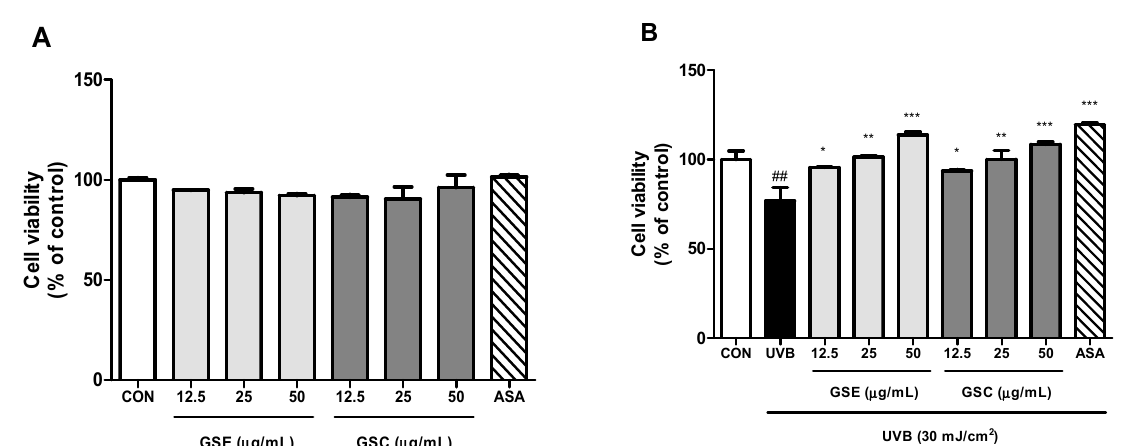
Figure 1. Effects of ginseng seed embryo (GSE) and coat (GSC) on Hs68 cells. ( A ) Cytotoxic effect of GSE and GSC on Hs68 cells was evaluated using MTT assay. ( B ) Protective effect of GSE and GSC in UVB-irradiated Hs68 cells was evaluated using MTT assay. Values are expressed as the mean ± standard error ( n = 3). ## p < 0.01, significant difference compared to control; *, **, and *** p < 0.05, 0.01, and 0.001, respectively, significant difference compared to UVB-irradiated group. ASA (ascorbic acid, 100 μ M), positive control.